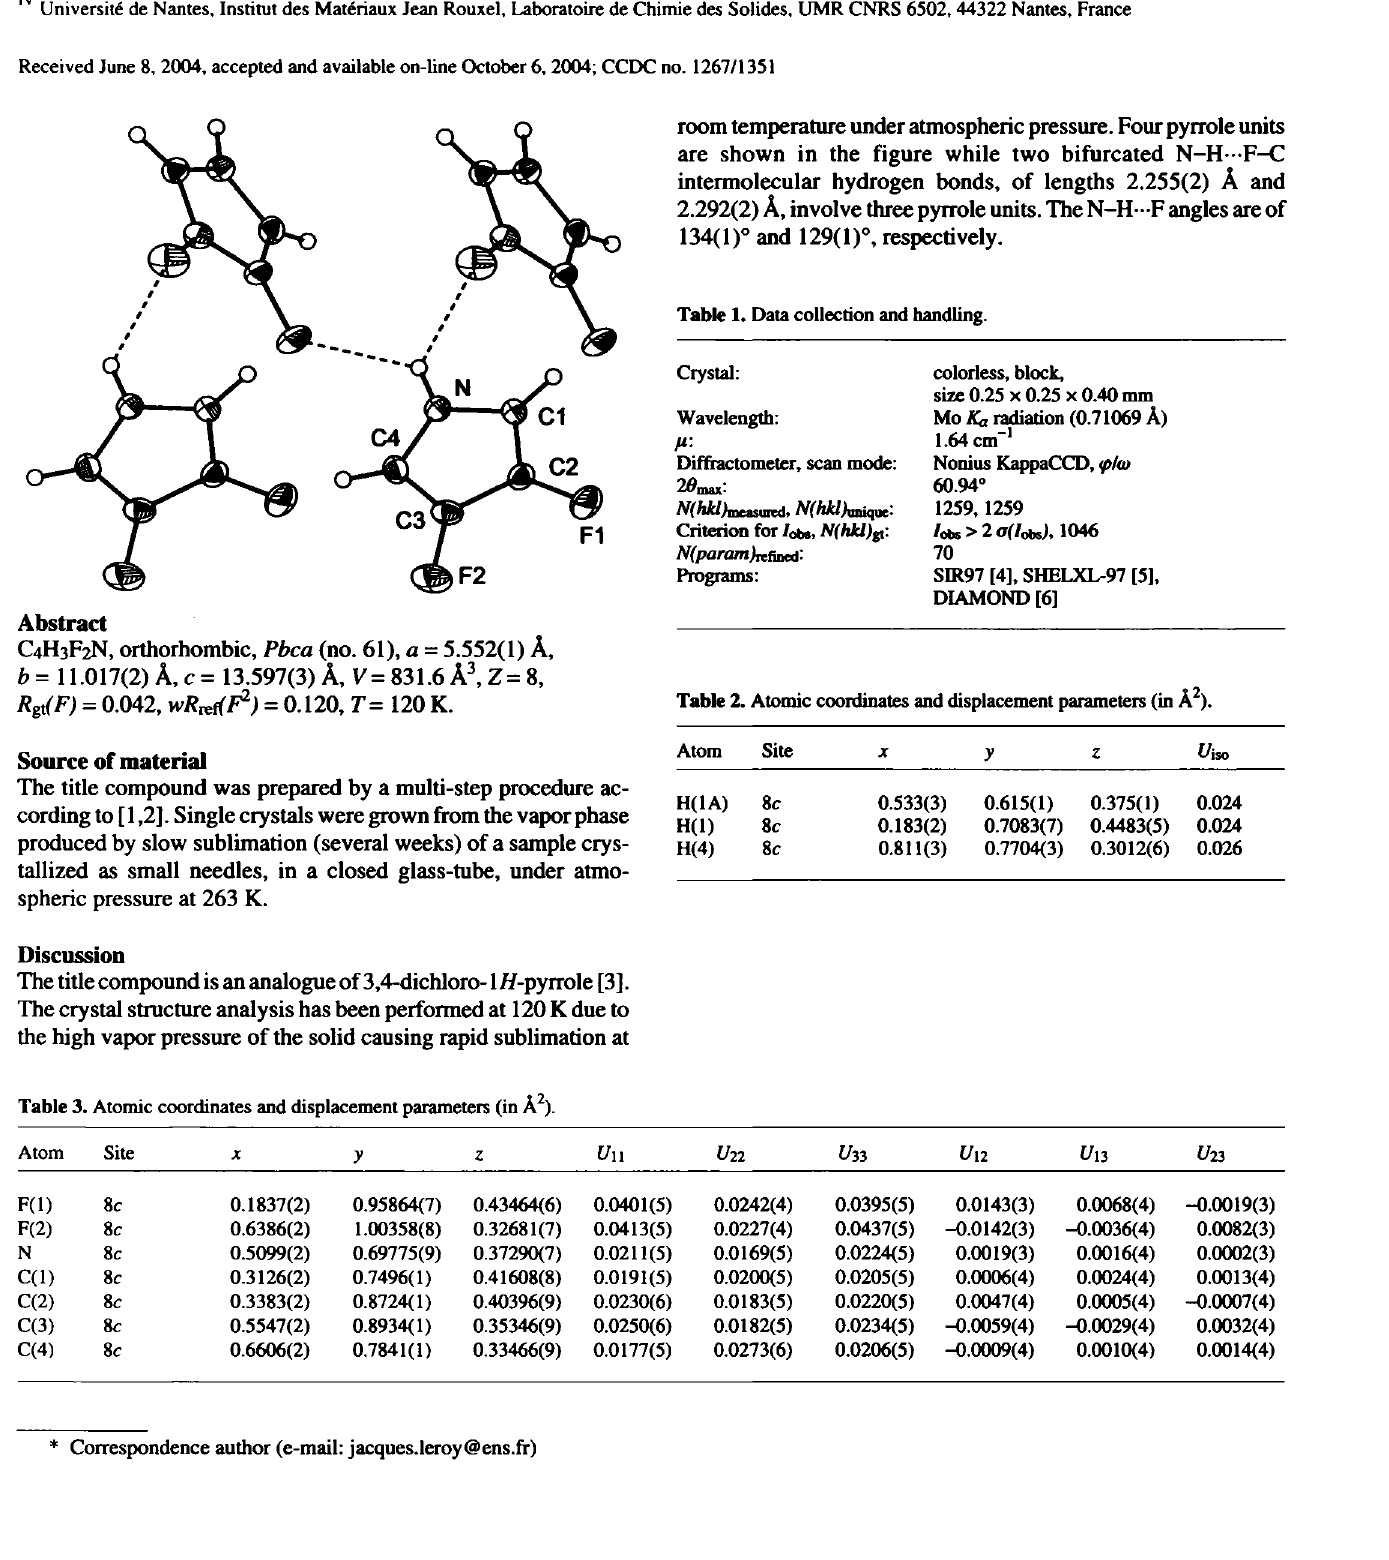
Table 1. Data collection and handling.